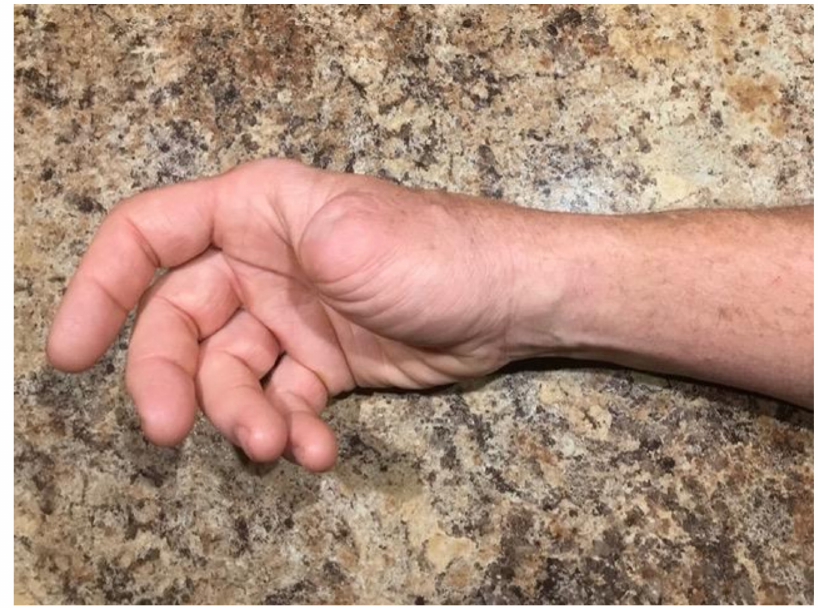
Figure 3. Resolution of right wrist invasive porocarcinoma cutaneous metastasis after completion of IL-2 injection